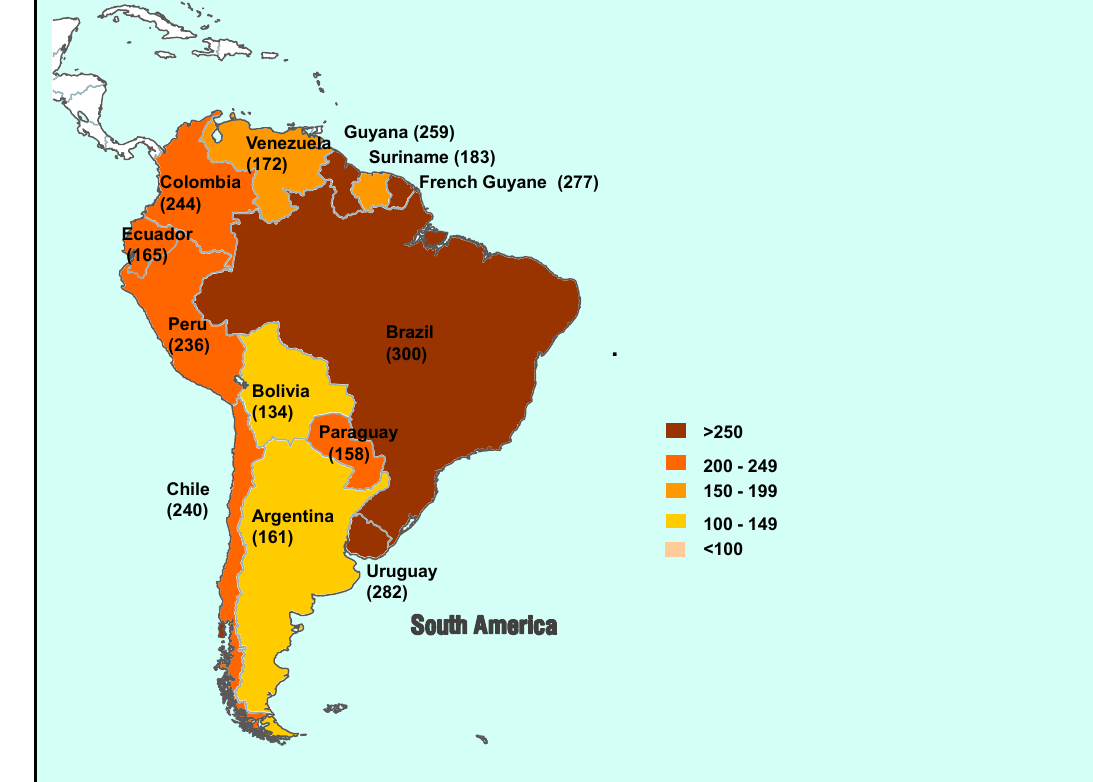
Figure 2: Incarceration rates, South America, 2014/2015 (latest year available)